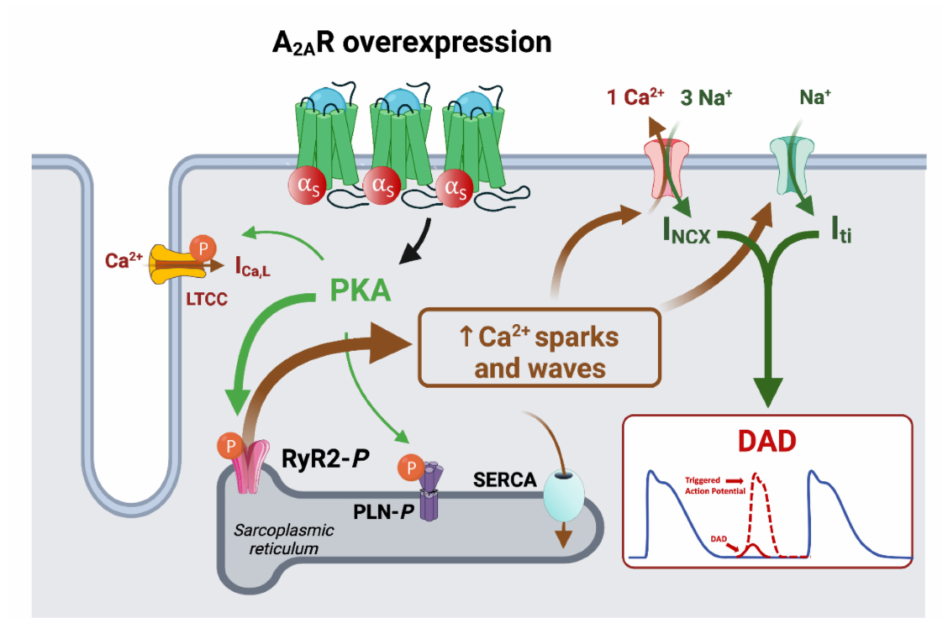
Figure 8. Remodeling of the calcium handling associated with A 2A R overexpression in AF. Atrial remodeling in atrial fibrillation is associated with the overexpression of A 2A R. This is responsible for an increased phosphorylation state of ryanodine receptors into dyads, which can induce diastolic Ca 2+ leaks without modulating the L-type Ca 2+ current. In parallel, the cytosolic Ca 2+ overload activates the Na + -Ca 2+ antiporter exchanger to remove Ca 2+ from cells with an accepted stoichiometry of 3Na + :1Ca 2+ . Consequently, the associated cytosolic Ca 2+ diastolic overload and the increased cation inward currents can induce delayed afterdepolarizations, which can be sufficient to meet the threshold cell membrane voltage and to trigger an action